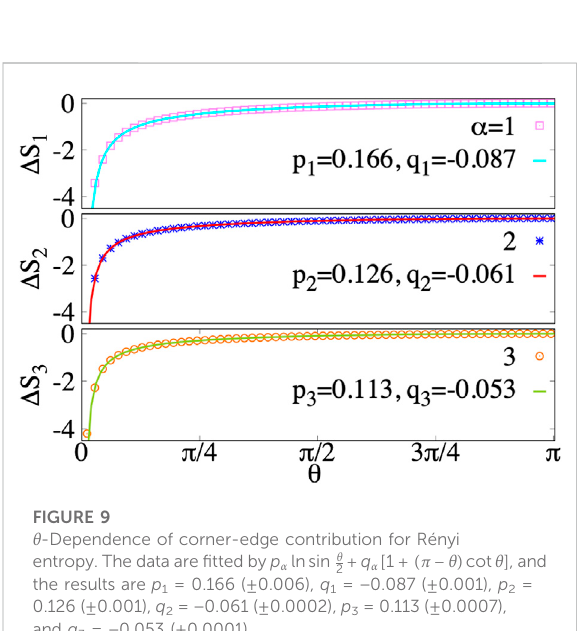
+ q α [ 1 + ( π − θ ) cot θ ] , and 2